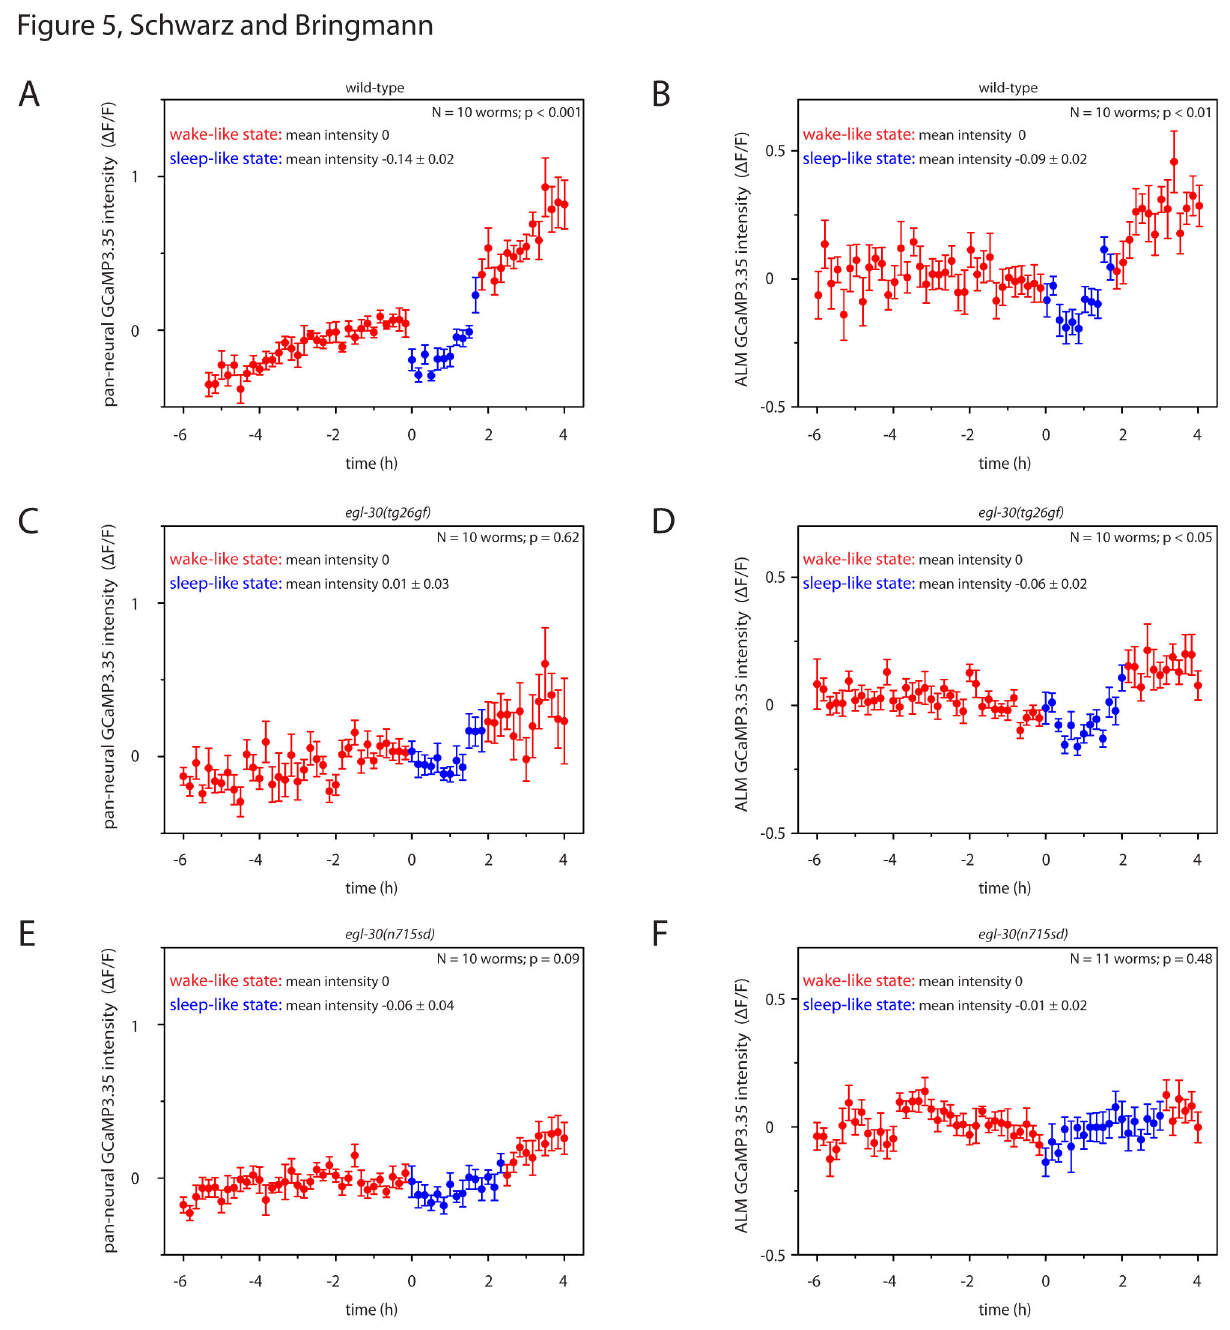
Figure 5. Reduced decrease of spontaneous neural activity in egl-30 mutants during sleep-like behavior. A Spontaneous pan-neural activity was reduced during wild type lethargus. B Spontaneous ALM activity was reduced during wild type lethargus. C Spontaneous pan-neural activity and D ALM activity in egl-30 (tg26gf) was reduced less than in wild type during lethargus. E Spontaneous pan-neural activity and F ALM activity in egl-30 (n715sd) was reduced less than in wild type during lethargus. Error bars represent SEM. The beginning of lethargus was arbitrarily set to 0h. Baseline fluorescence during the two hours of wake-like behavior preceding lethargus was set to zero. Statistical test used was Wilcoxon Signed Ranks.